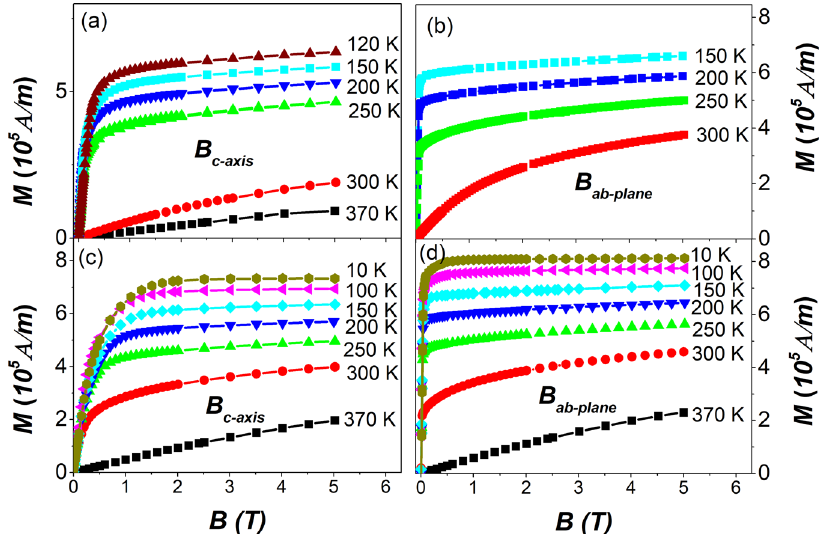
Fig. 4 Magnetic fi eld dependent magnetization curves. The external fi eld B is applied along the c-axis and in the ab-plane at different temperatures, while the magnetization M is measured. a , b for the pre-cooling and c , d for the post-cooling phase. The standard deviation of each data point is smaller than 100 A/m and as such smaller than the displayed